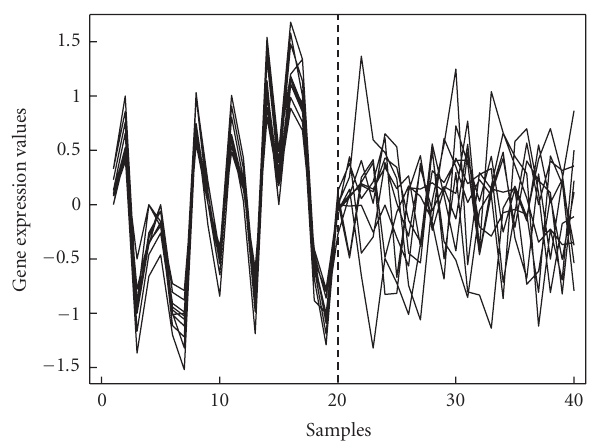
Figure 1: Illustration of di ff erentially coexpressed (DEC) disease gene subset between normal samples and disease samples. The left 20 samples are normal samples and the right 20 samples are disease